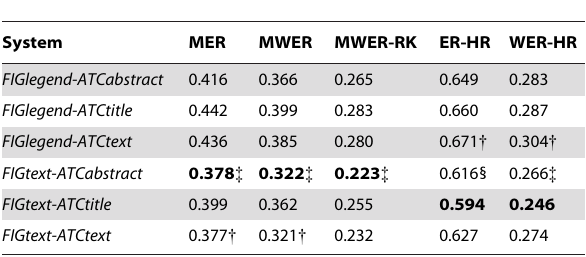
Table 1. Performance of automatic figure ranking based on similarities between different representation of figures and